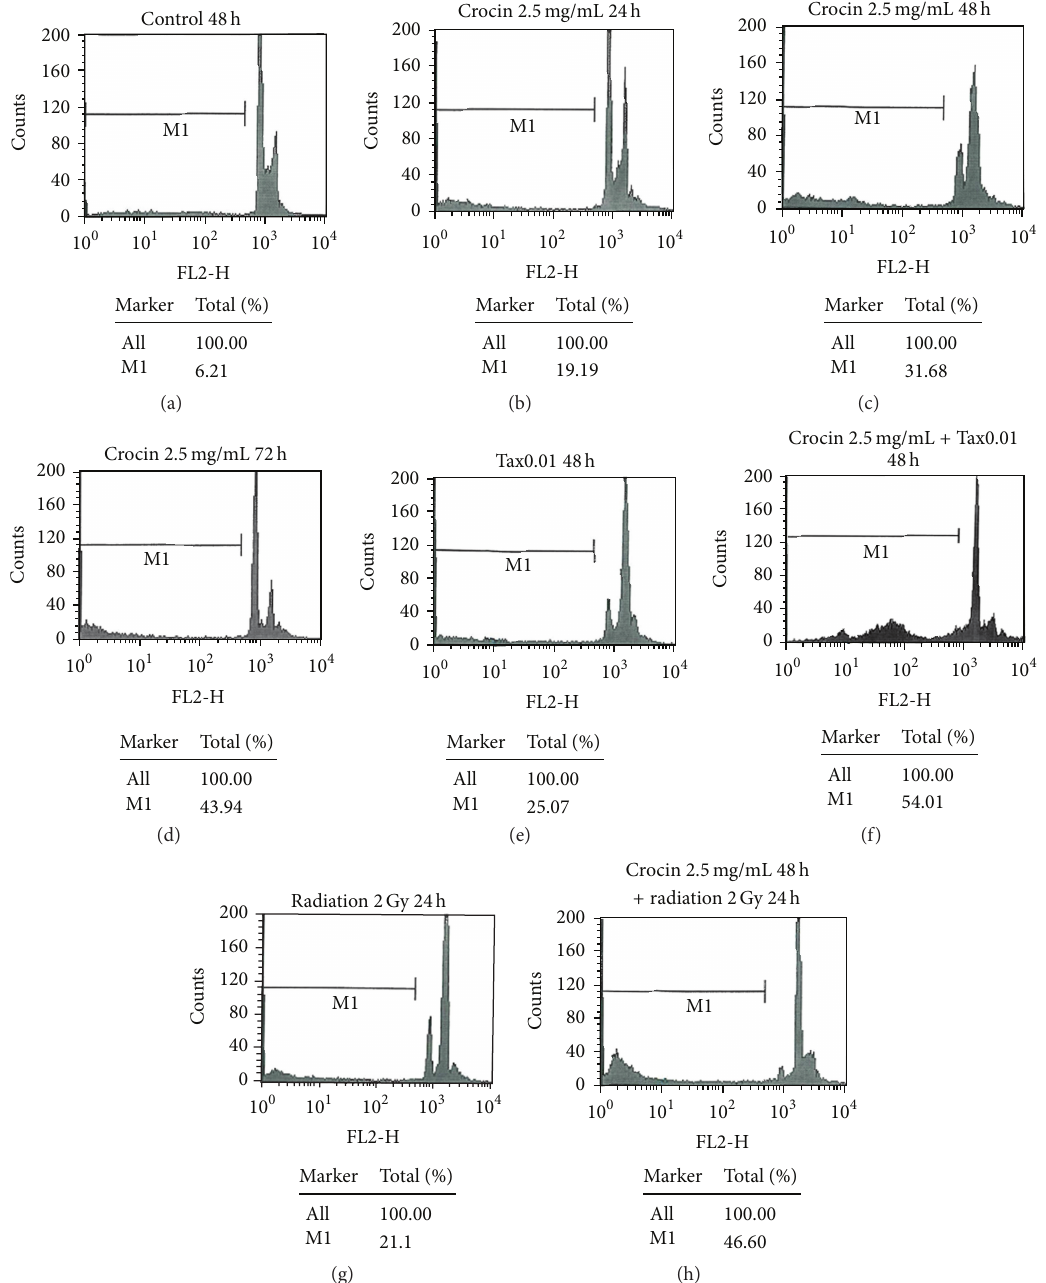
Figure 4: Measurement of apoptosis by PI flow cytometry: (a) control 48 h, (b) crocin 2.5 mg/mL 24 h, (c) crocin 2.5 mg/mL 48 h, (d) crocin 2.5 mg/mL 72 h, (e) paclitaxel 0.01 𝜇 m/mL, (f) crocin 2.5 mg/mL + paclitaxel 0.01 𝜇 m/mL, (g) radiation 2 Gy 24 h, and (h) crocin 2.5 mg/mL 48 h + radiation 2 Gy 24